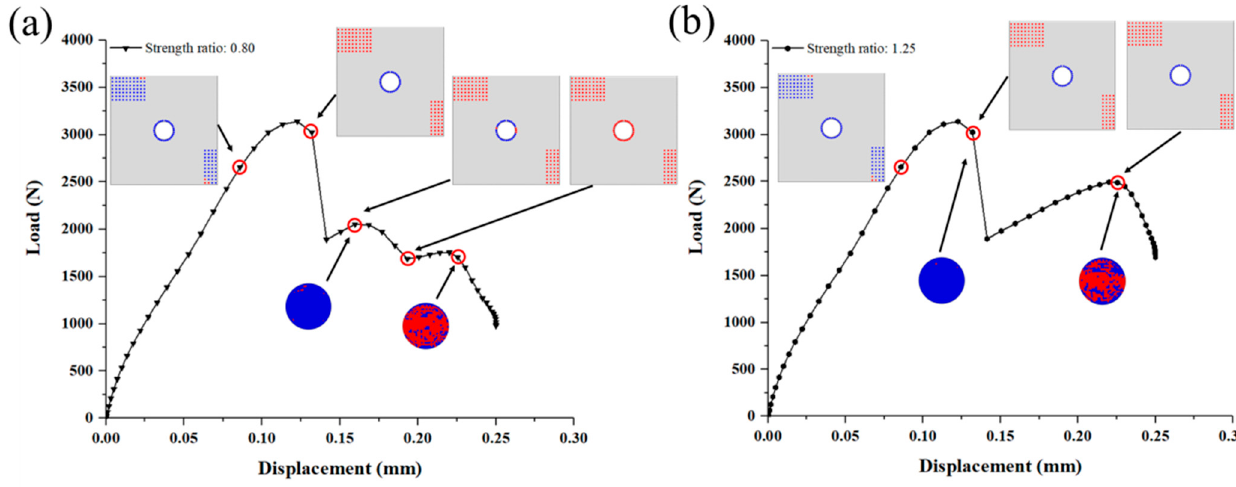
Figure 15. Progressive failure of the joint when the strength of SiC matrix in deposition zone B (DZB) is ( a ) 0.8 times; ( b ) 1.25 times the original value.